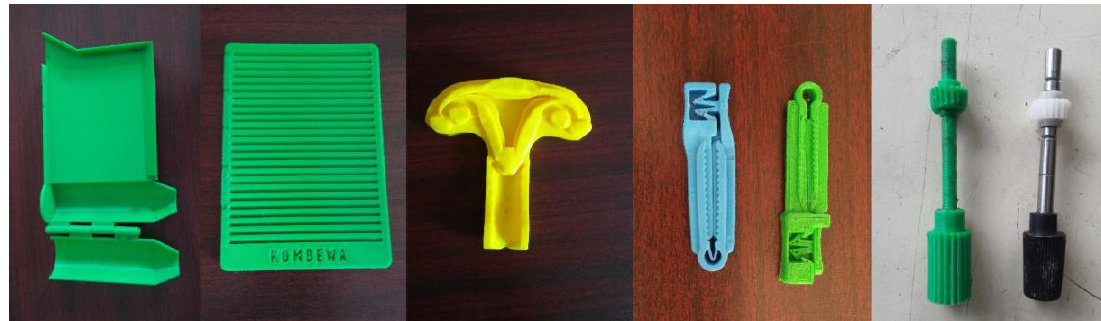
Figure 11. Examples of 3-D-printed medical parts created by the Kijenzi printer include, (from left to right ), a pill sorter, a slide dryer, a uterine model, a replica of an umbilical cord clamps, and a replacement knob for a microscope.